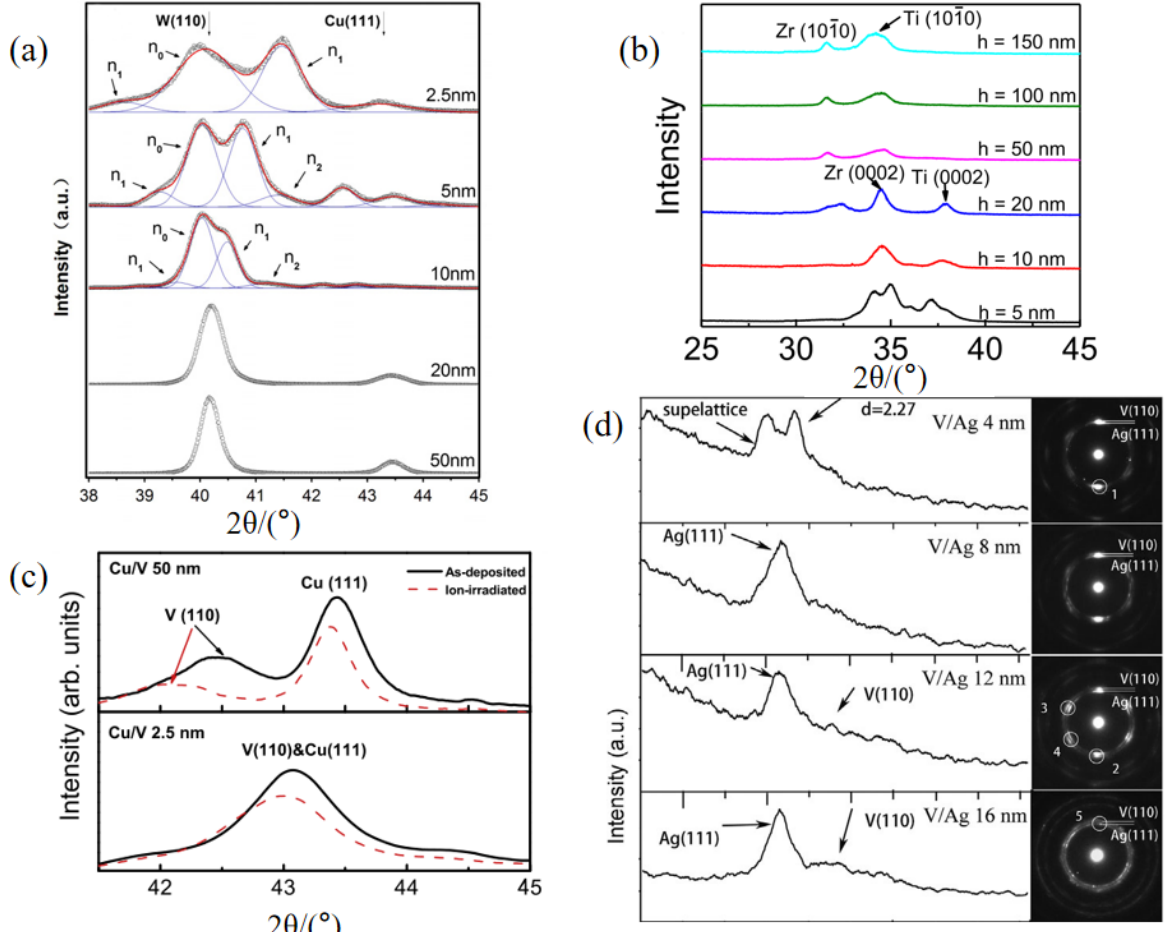
Figure 8. XRD patterns of ( a ) Cu/W [4], ( b ) Ti/Zr [77], ( c ) Cu/V [75], and ( d ) Ag/V [74] multilayer films with various layer thicknesses. The selected-area electron diffraction (SAED) patterns of Ag/V multilayer films are also shown in ( d ). The results indicate that interface coherency increases with decreasing layer thickness. Reprinted with permission from [4]